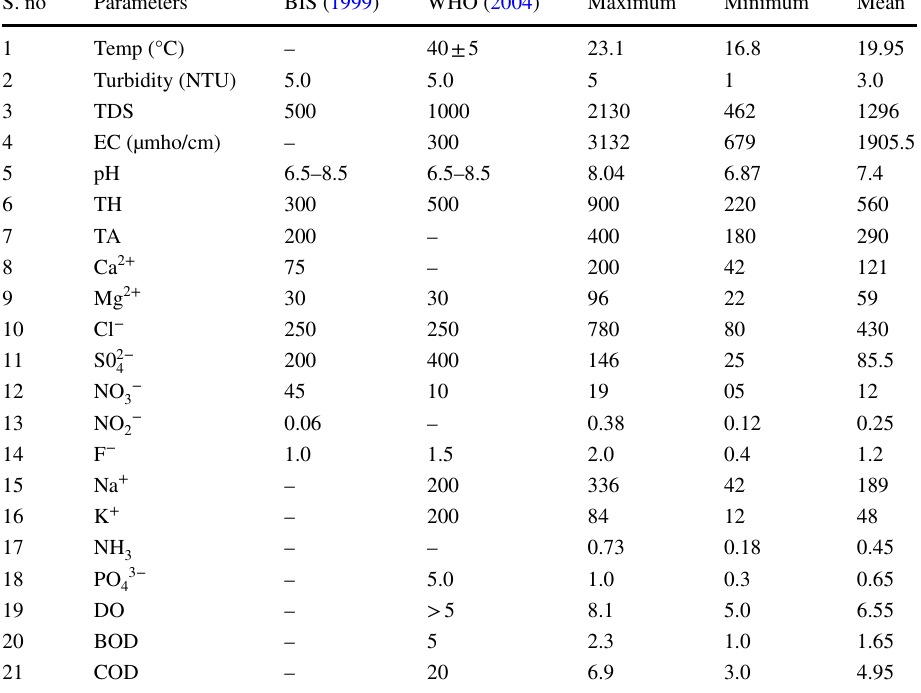
All parameters are expressed in mg/L except Temp, Turbidity, EC